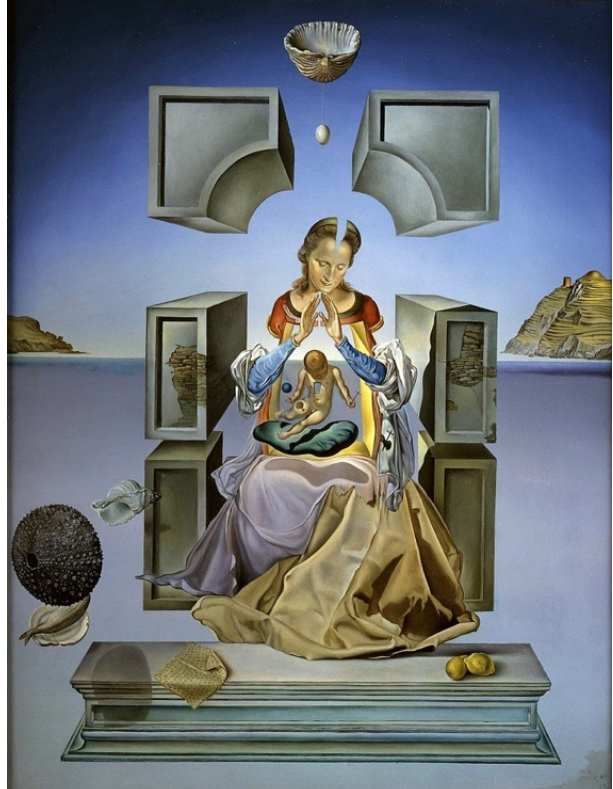
Figure 2. Salvador Dalí, First Study for the Madonna of Port Lligat, 1949 . Photo by Lluisribesma- teu1969, Fair Use .